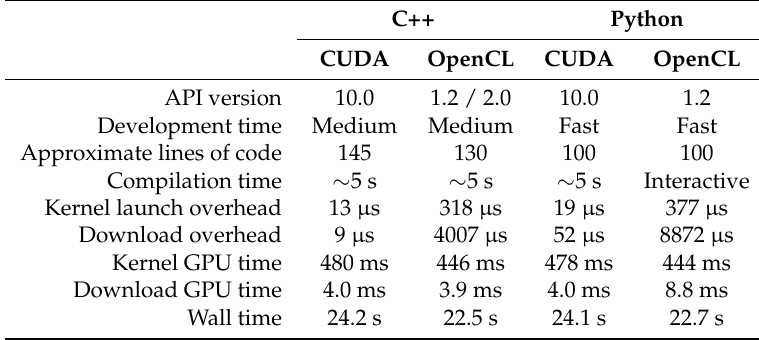
Table 1. Performance of Compute Unified Device Architecture (CUDA) and Open Compute Language (OpenCL) for the Mandelbrot application from both Python and C++. The code was run on an Nvidia Tesla M2090 graphical processing unit (GPU) to compute fifty consecutive zooms onto the point 0.75 + 0.1 i with a maximum of 5000 iterations. OpenCL 2.0 is available in the host section of the code, − but the device section must still use OpenCL 1.2 for the C++ version. The development time is set subjectively by the authors and the lines of code metric contains only the central processing unit (CPU) code related to the actual GPU kernel launch. On Windows, we were unable to get asynchronous execution with OpenCL on several different machines, Python versions, and GPU driver versions. We have not been able to pinpoint the cause of this and suspect that asynchronous execution of OpenCL in Windows is not fully supported. We used page locked memory with CUDA, whilst this was not easily available through OpenCL for the download. The overhead for OpenCL therefore includes the transfer, as it cannot be run concurrently with other operations. It should be noted that OpenCL should support efficient pinned memory transfers, but we were unable to get this to work using several driver versions on several different machines. We therefore report the observed transfer times without pinned memory. The wall time includes all the time the CPU spends from launching the first kernel to having completed downloading the last result from the GPU. C++ Python CUDA OpenCL CUDA OpenCL API version 10.0 Development time Medium Medium Fast Fast Approximate lines of